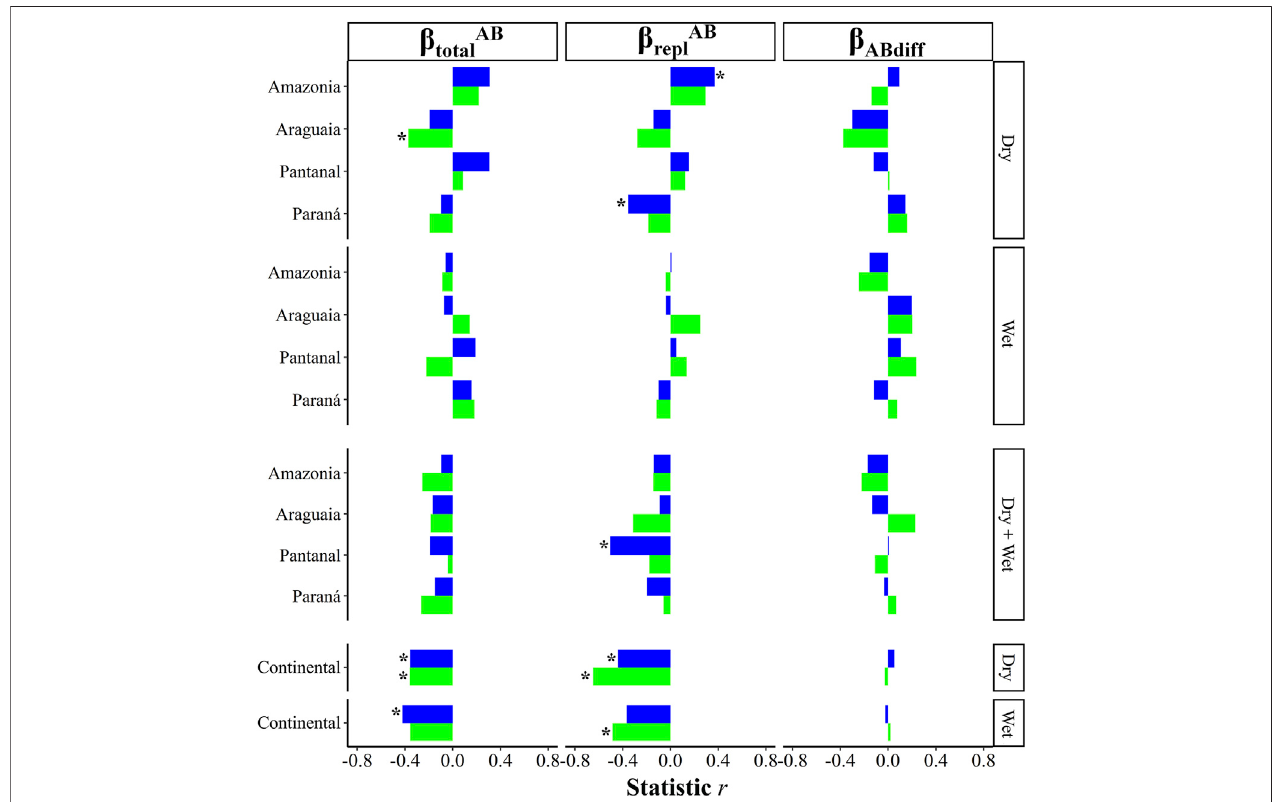
FIGURE 6 | Mantel test results showing the r -statistic between the observed congruence and the functional distances between biological groups for presence- absence data. Blue = Taxonomic facet; Green = Functional facet. * p < 0.05.